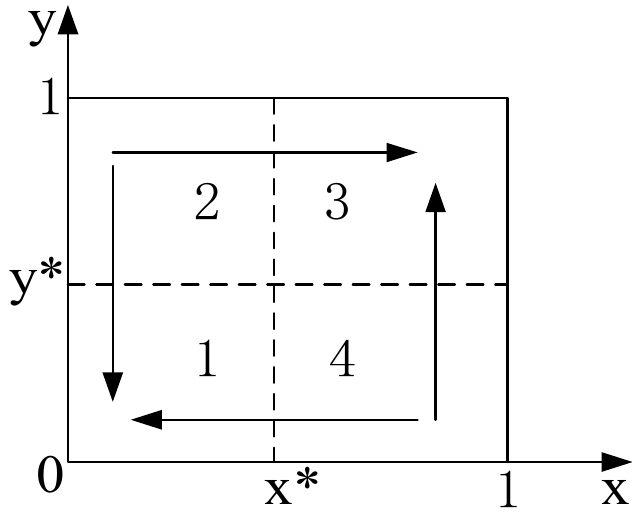
Figure 4. Copy the dynamic phase diagram in the initial stage.